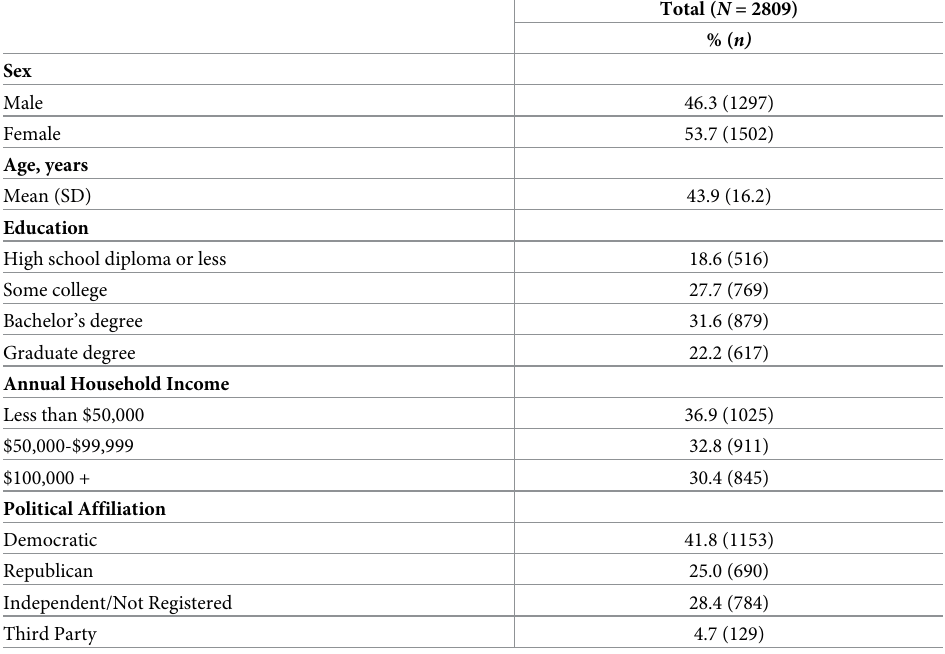
Table 1. Descriptive statistics for total sample across